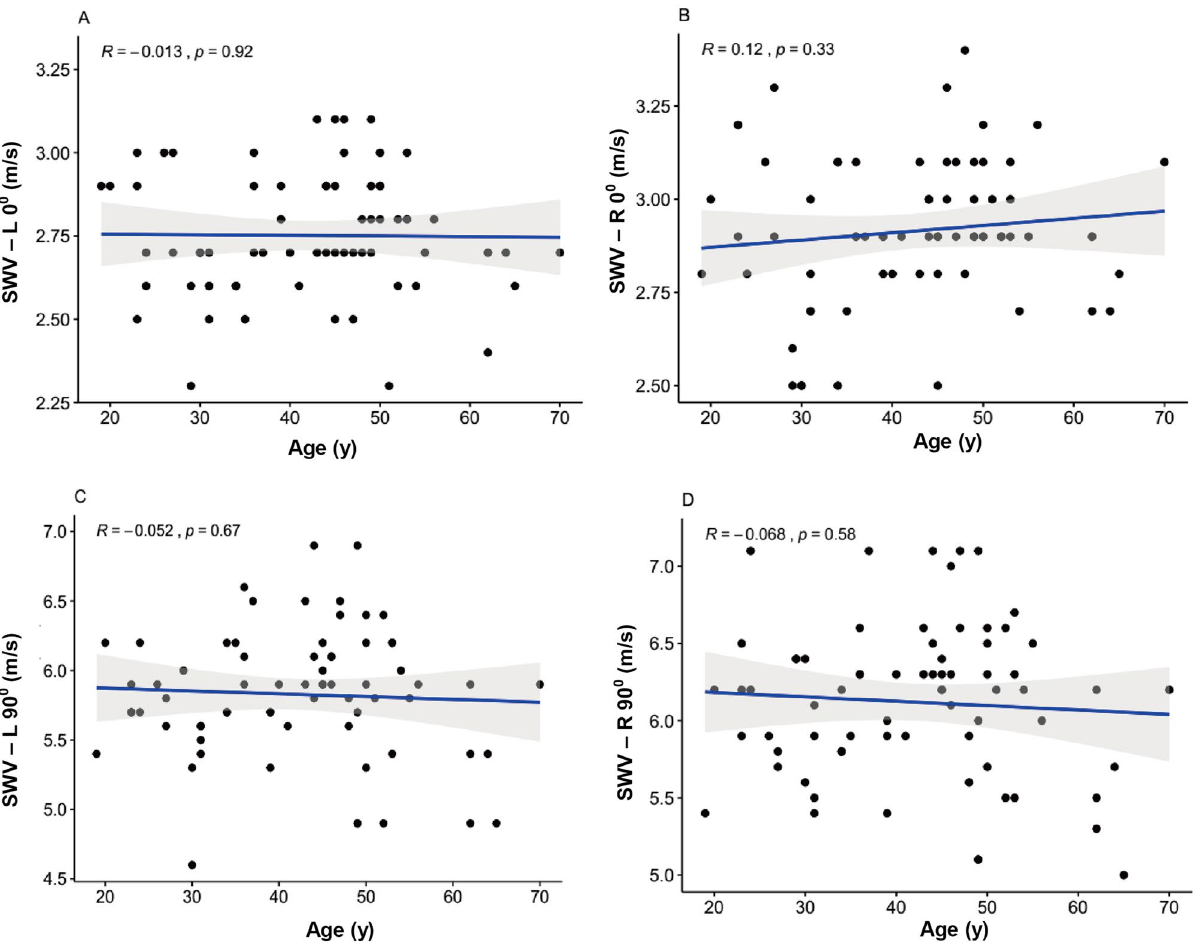
Figure 6. Scatterplots of age and SWV in healthy participants at L0° ( A ), R0° ( B ), L90° ( C ), and R90° ( D ). SWV mean shear wave